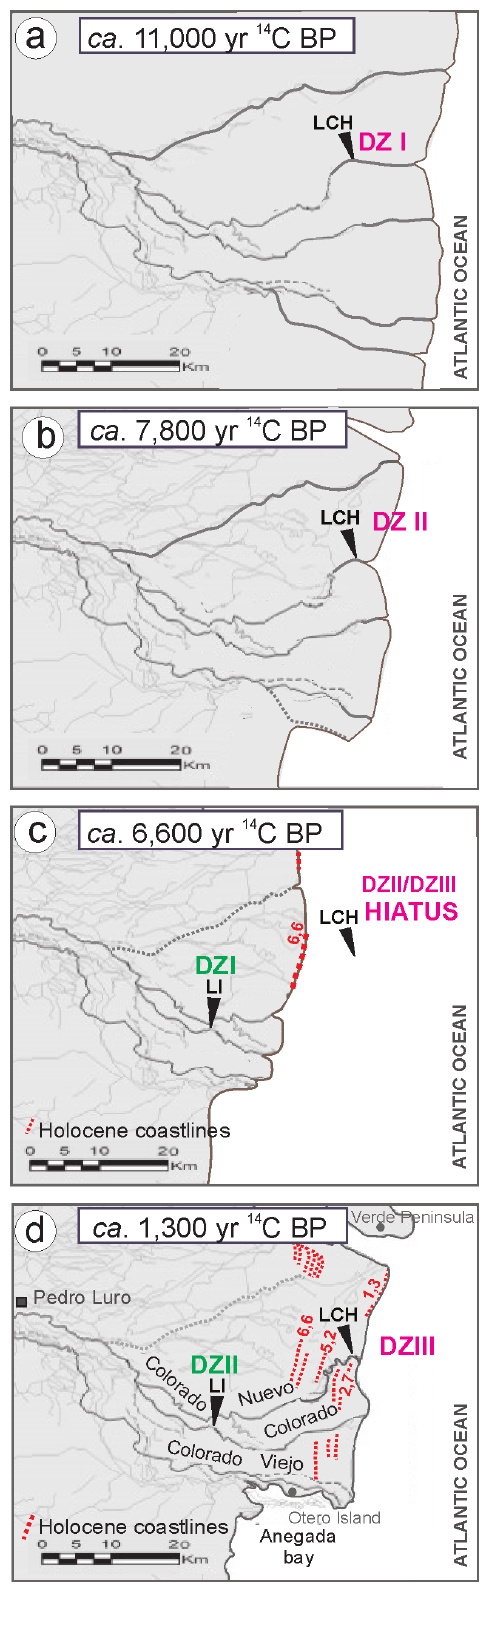
Figure 5. a-d. Conceptual model of the three phases in the hydrological evolution of the LCH site based on diatom zones (pink) and its integration with others evidence from the area (Holocene’s coastline positions and LI-core diatom assemblages’ interpretation). a- Late Pleistocene-Early Holocene. Tidal flats developed in the sea level rising and tidal channels from the LCH site were clogged